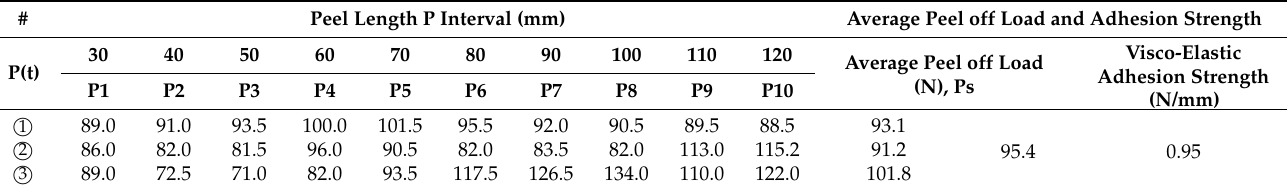
Table 8. VG-4 viscoelastic adhesive strength test